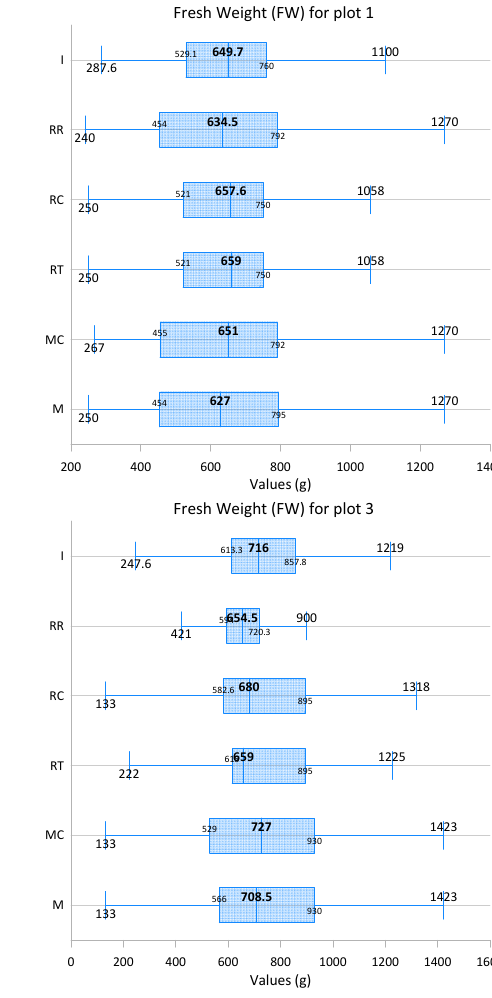
Figure 4. Fresh Weight (FW) descriptive statistics for the different sampling methods: M: Measured (all data); MC: Measured cut (without the measurements from the upper part area—lines 20 to 25); RT: Missing values were replaced by the total average of all values; RC: Missing values were replaced by the average of the column, where the missing value belongs to; RR: Missing values were replaced by the average of the row, where the missing value belongs to; I: Interpolation.